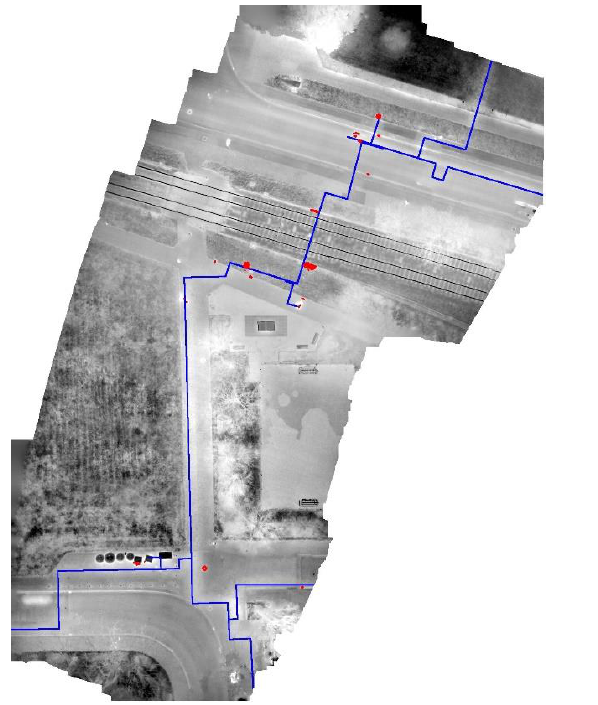
Figure 10 Anomaly detection - flight site 1